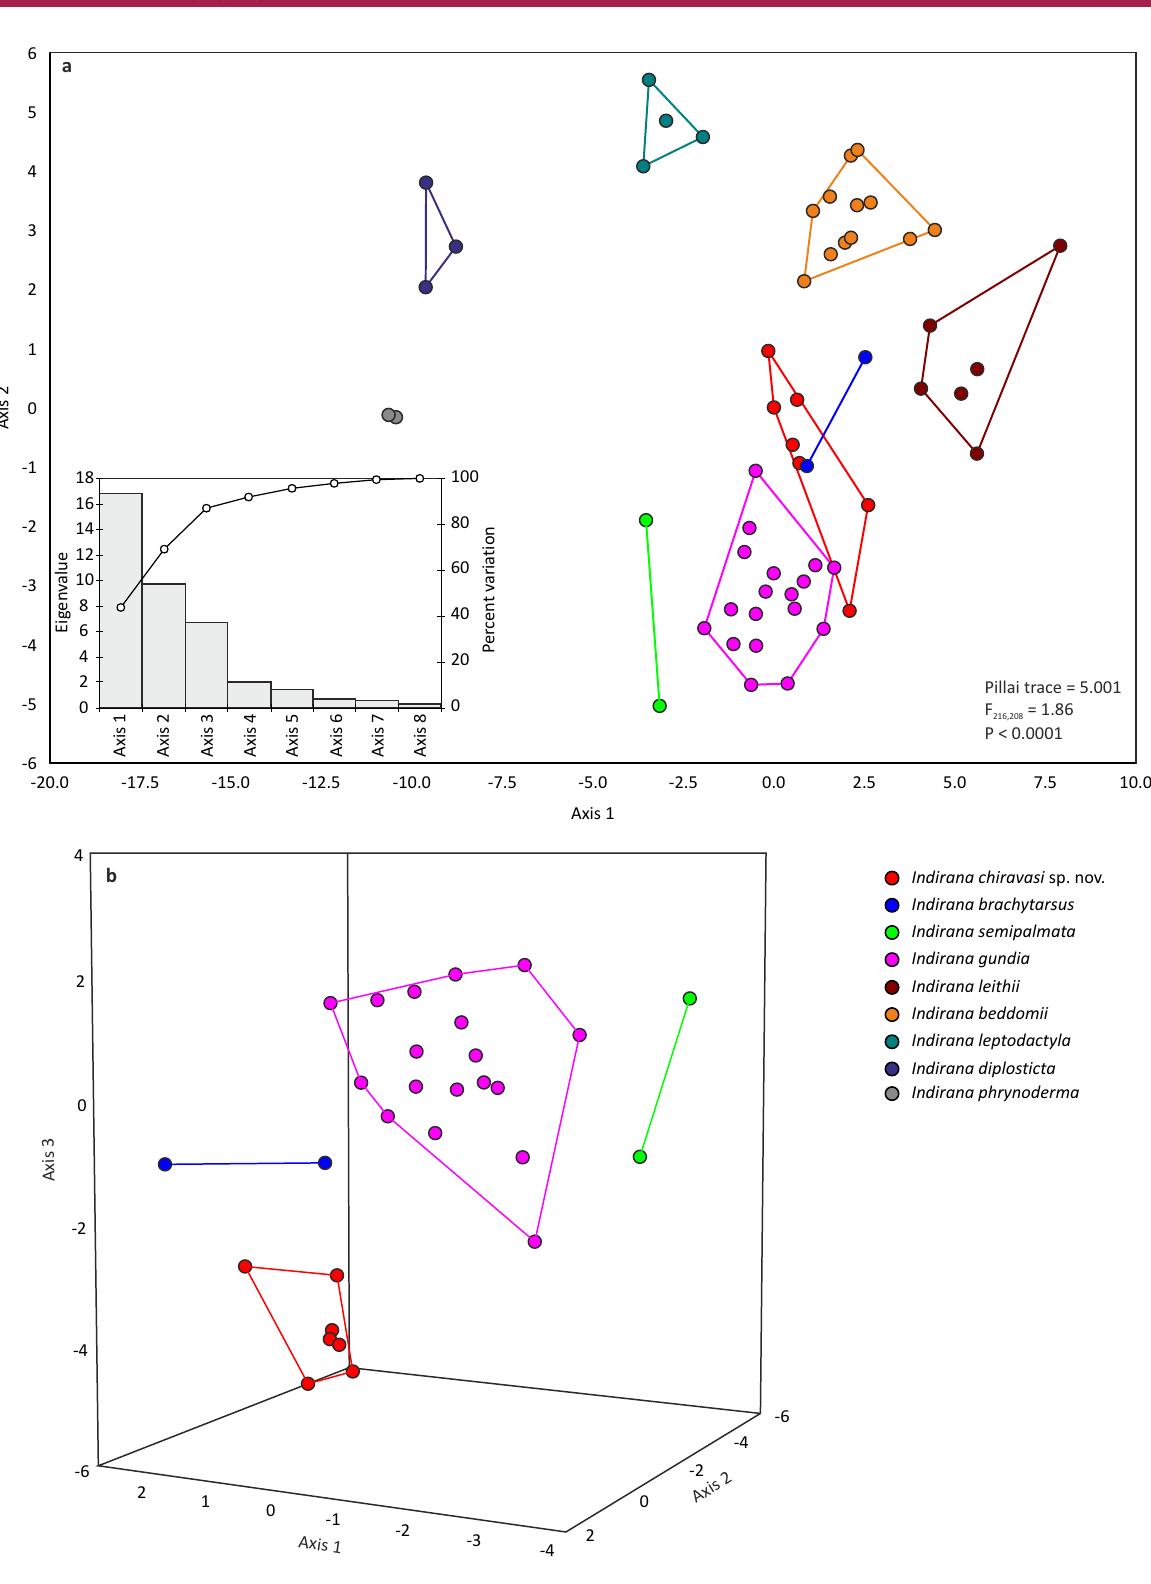
Figure 2. Multivariate Analysis of Variance – Canonical Variates Analysis (MANOVA-CVA) of morphometric data of Indirana species. (a) CVA on first two canonical axes, scree plot is shown in the inset, and (b) CVA on first three canonical axes for morphometrically closely related species to Indirana chiravasi sp.